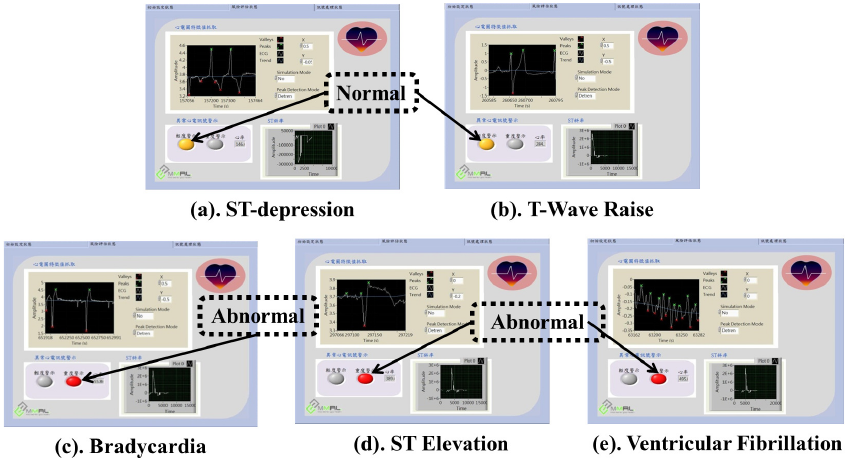
Figure 16. Results of various ECG abnormalities detection.